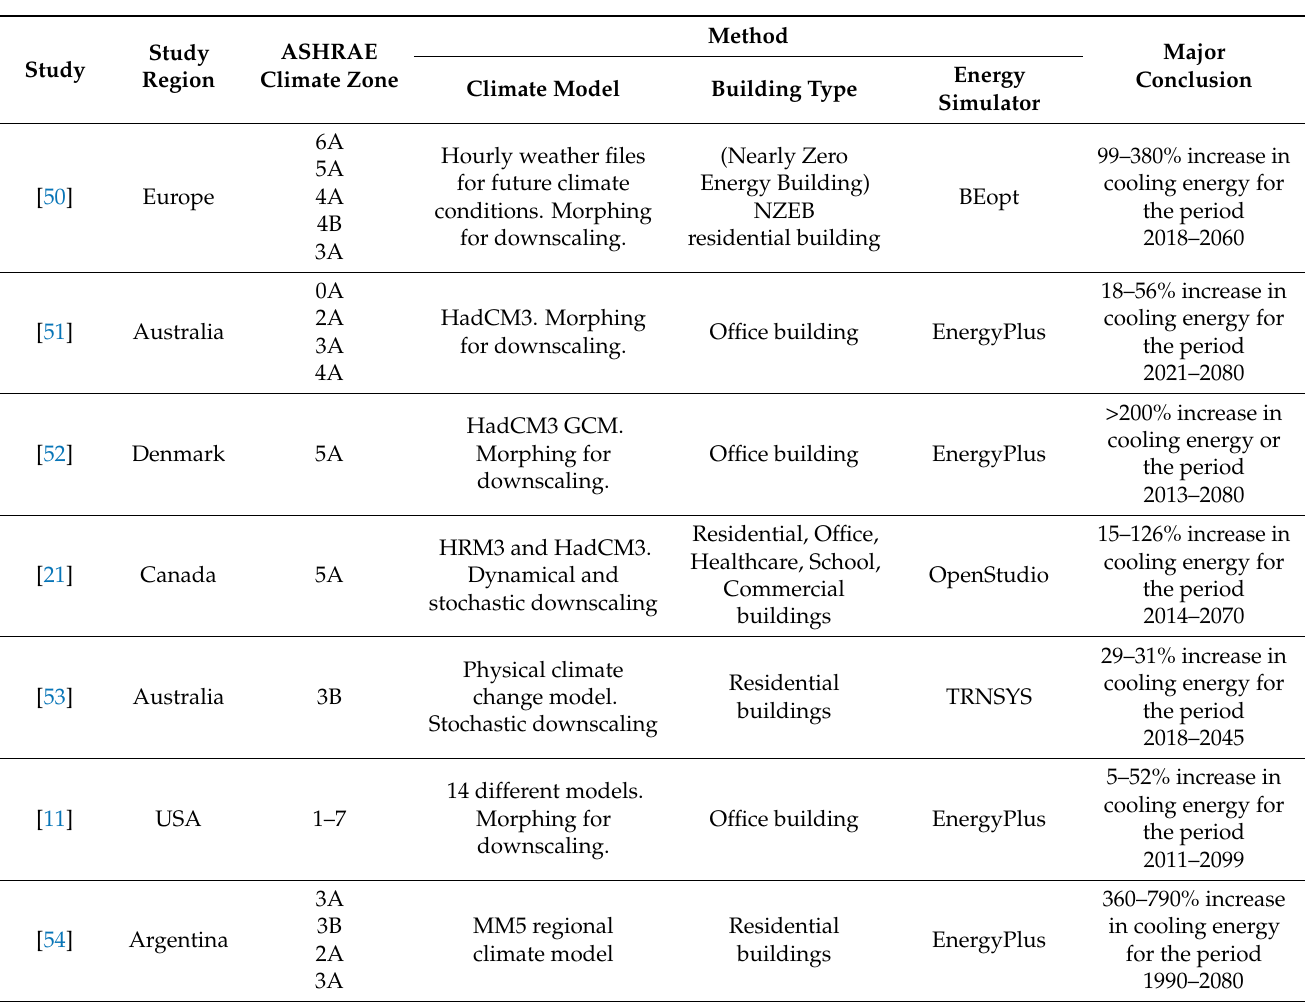
Table 1. Summary of previous literature about the impact of climate change on the cooling demand of